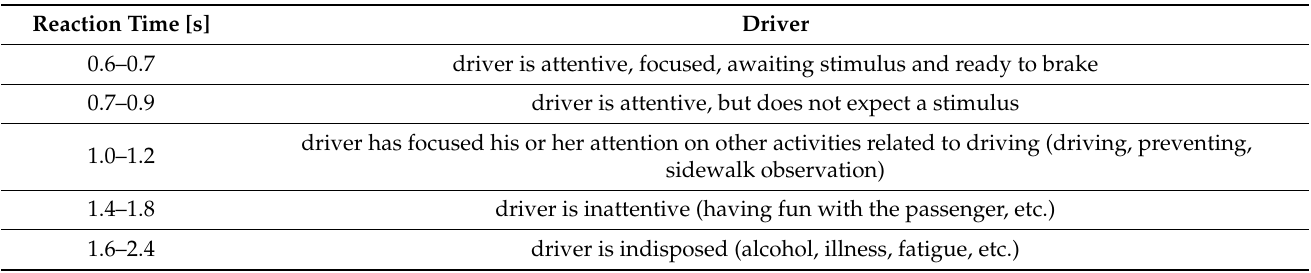
Table 1. Drivers’ reaction times for different conditions. Source: [59].